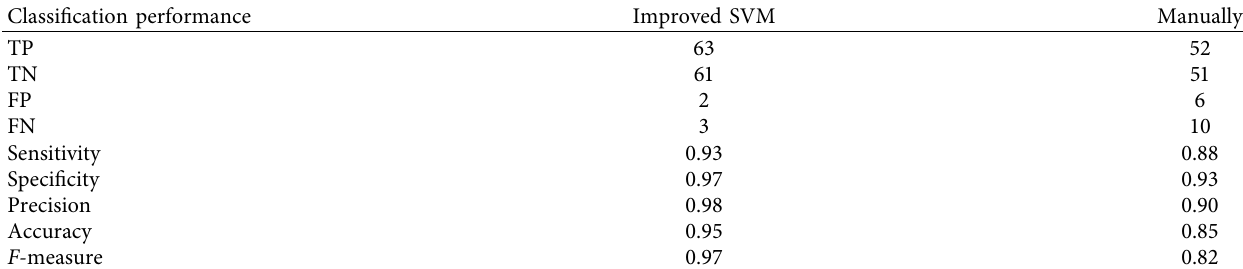
Table 5: Classification performance results for training